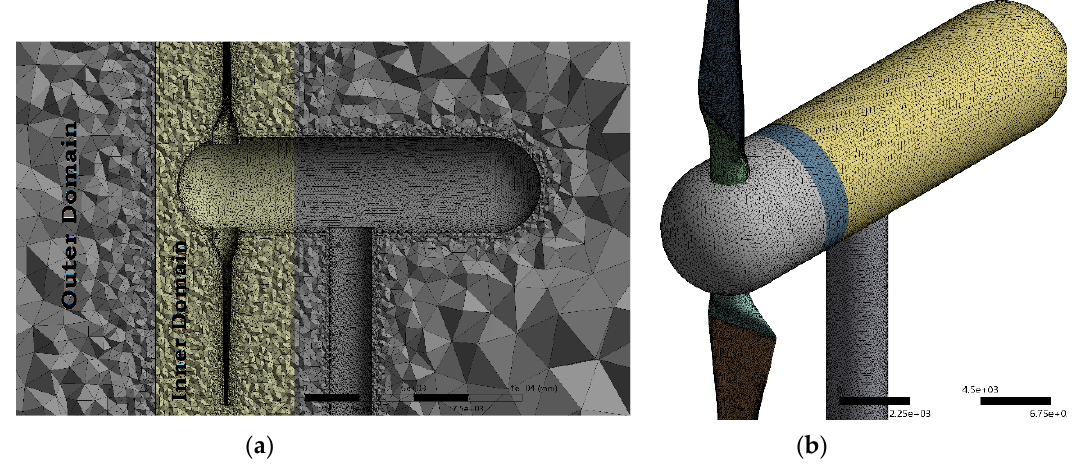
Figure 3. Mesh used for the simulations ( a ) CFD Mesh; ( b ) FEA Mesh.